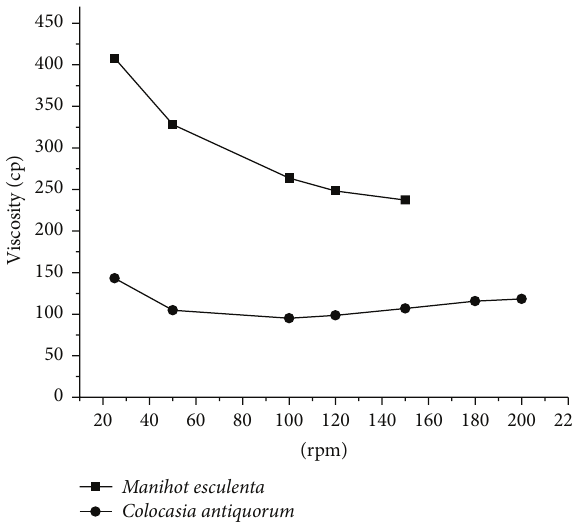
Figure 3: Water absorption, solubility, and swelling power capacity of Colocasia antiquorum ( ◼ ) and Manihot esculenta ( e ) starch. Figure 4: Apparent viscosity of Colocasia antiquorum and Manihot esculenta